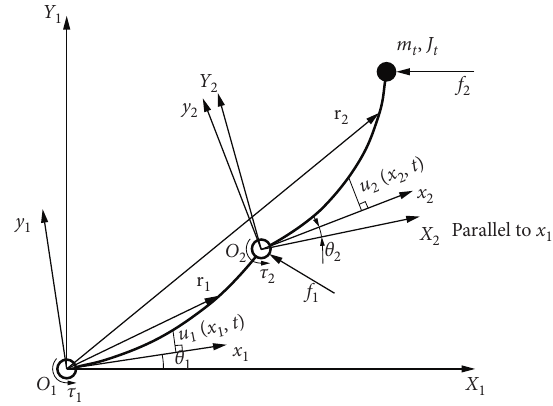
Figure 1: Sketch of the two-link flexible manipulator